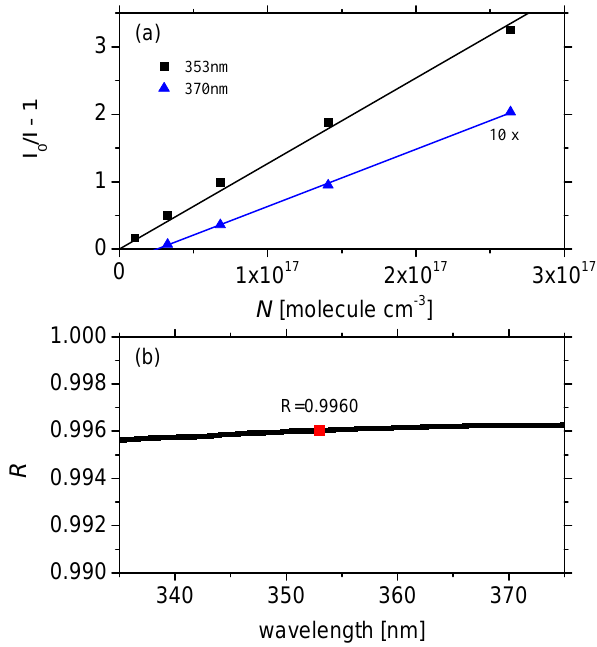
Fig. 2. (a) Fractional absorption of O 3 at 353nm and 370nm. The Figure 2. (a) Fractional absorption of O 3 at 353nm and 370 nm. The slope of the graph, 3 slope of the graph, σ O3 d/( 1 − R) , was used to determine R based σ O3 d /(1 – R), was used to determine R based on the literature absorption cross-section at 4 on the literature absorption cross-section at 353nm. (b) Mirror re- flectivity scaled to give the literature cross-section of O 3 absorption 353 nm. (b) Mirror reflectivity scaled to give the literature cross-section of O 3 absorption at 5 at 353 nm. 6